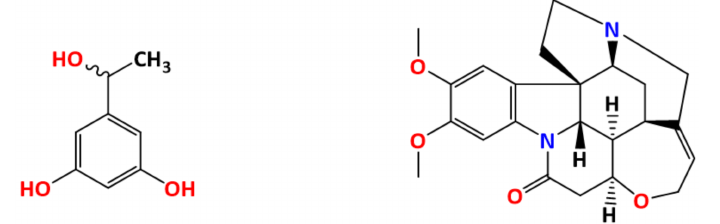
Figure 27. If RS-resorcylmethylcarbinol ( left ) and brucine ( right ) are co-crystallized from